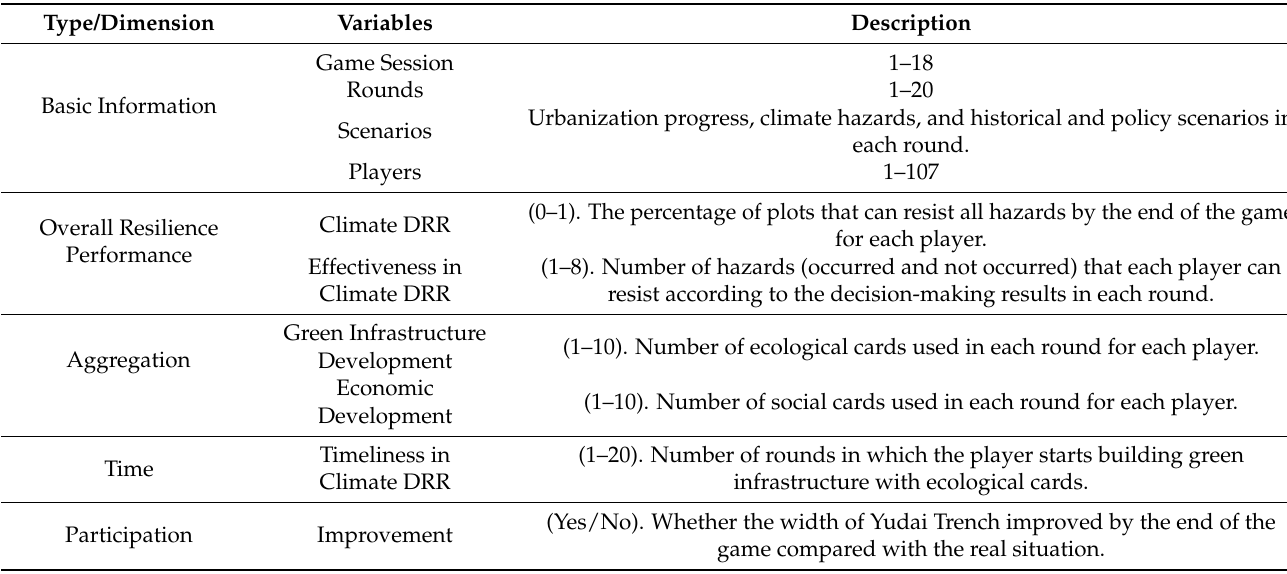
Table 3. Data needed to record during the in-game